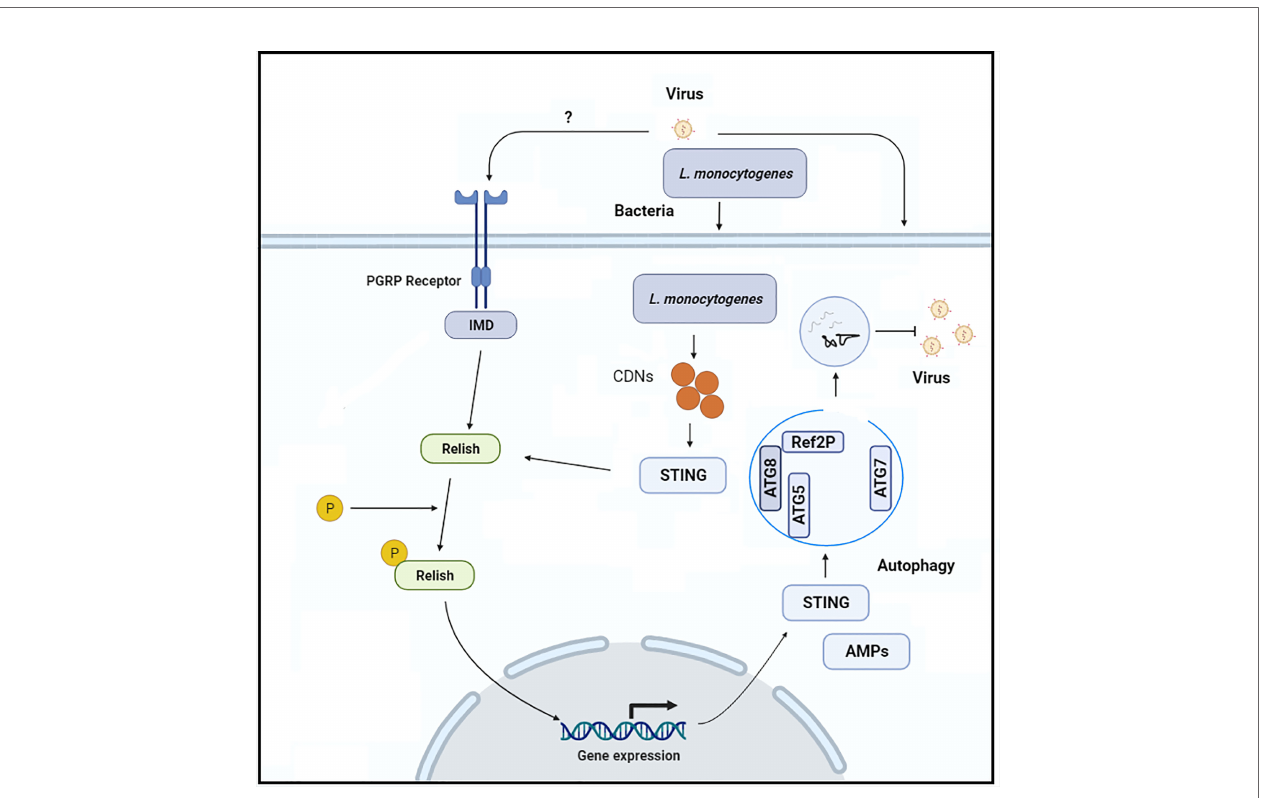
FIGURE 3 | the Schematic representation of the molecular mechanism through which Rel-NF- K B-dependent STING expression induces anti-viral autophagy in